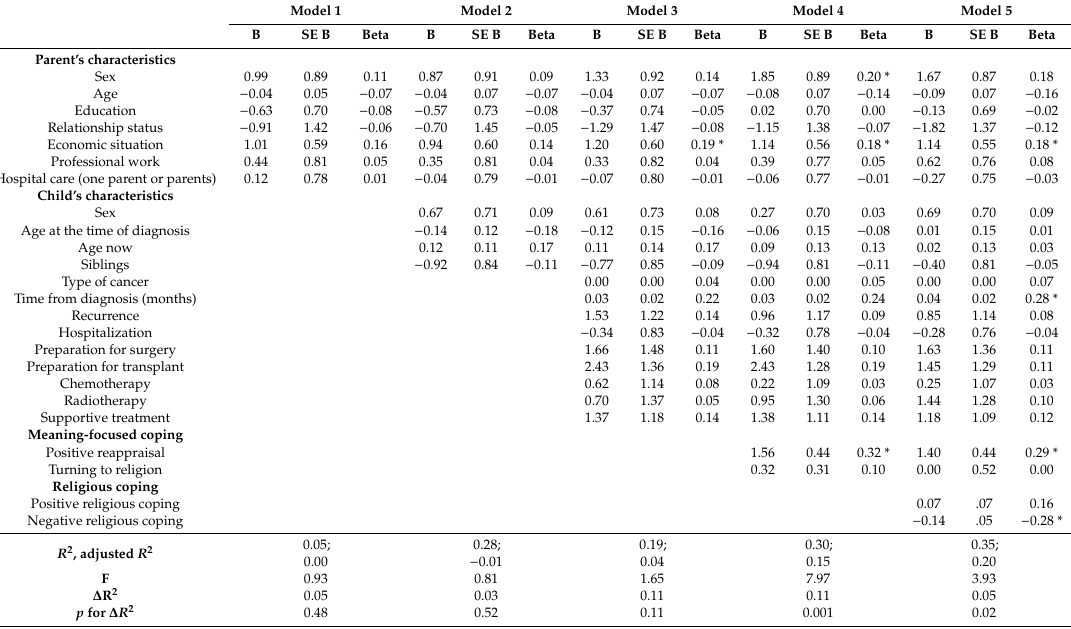
Table 2. Results of hierarchical regression analysis for positive